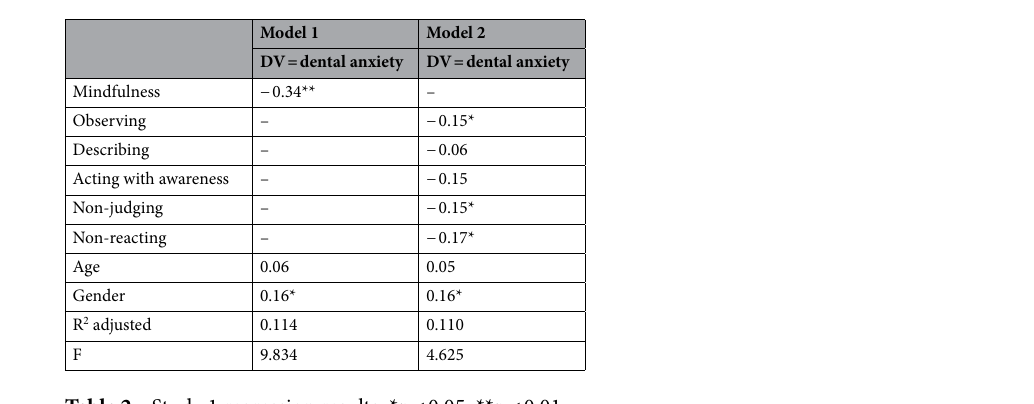
Table 2. Study 1 regression results. *p < 0.05, **p <